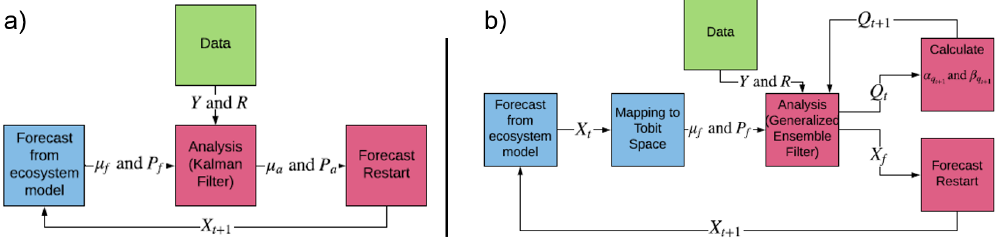
Figure 4. (a) Classic ensemble Kalman filter method. (b) Tobit–Wishart ensemble filter. X f : matrix of model forecasts; µ f and P f : forecast mean and error covariance matrix; µ a and P a : analysis mean and error covariance matrix; Y and R : observation mean and error covariance matrix; Q t model process error. Adopted from Raiho et al.